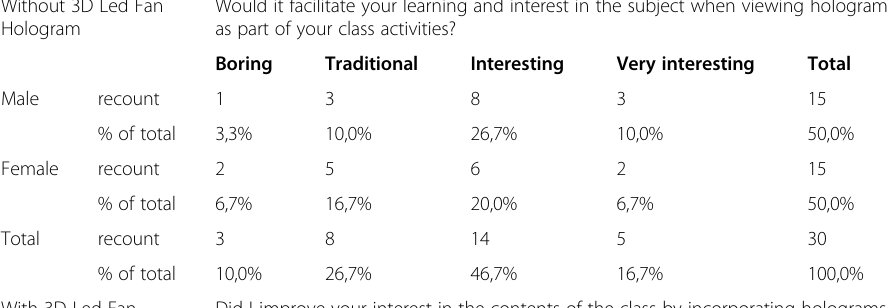
Table 6 Comparative pre and post- questionnaire about improving learning by applying techno- pedagogical. Cross reference Without 3D Led Fan